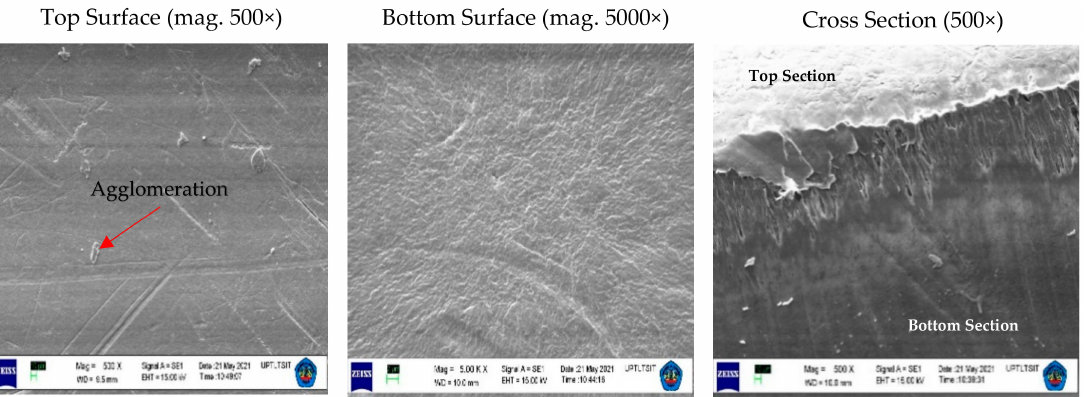
Figure 5. Structure of PVDF and tin dioxide membrane for 17.5 wt% PVDF with 1% tin dioxide. Top Section with Magnitude = 500 × , WD = 10.0 mm, EHT = 15.00 kV, Signal A = SE1. Bottom Section with Magnitude = 5.00 K × , Working Distance (WD) = 9.5 mm, EHT = 15.00 kV, Signal A = SE1. Cross Section with Magnitude = 500 × , WD = 10.5 mm, EHT = 15.00 kV, Signal = SE1.